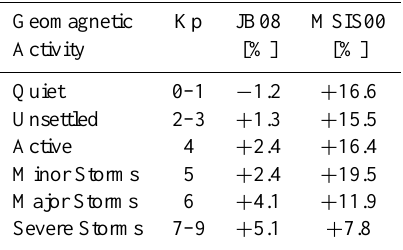
Table 3. Percentage deviation of the total mass densities evaluated with the empirical models JB08 and MSIS00 from the reference so- lution based on GRACE acceleration measurements. Investigation